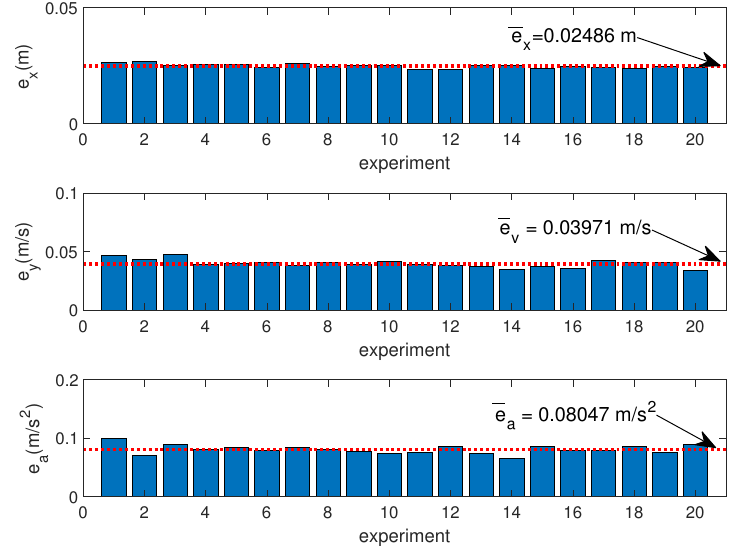
Figure 8. Displacement, velocity, and acceleration errors for different experiments.